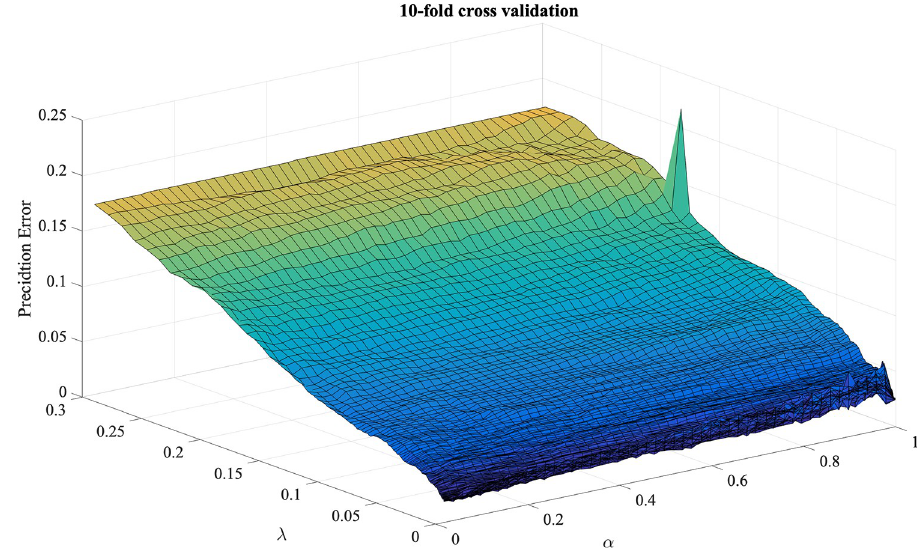
Fig 5. Real data analysis. The results of 10-fold CV: Prediction error in various parameters settings.